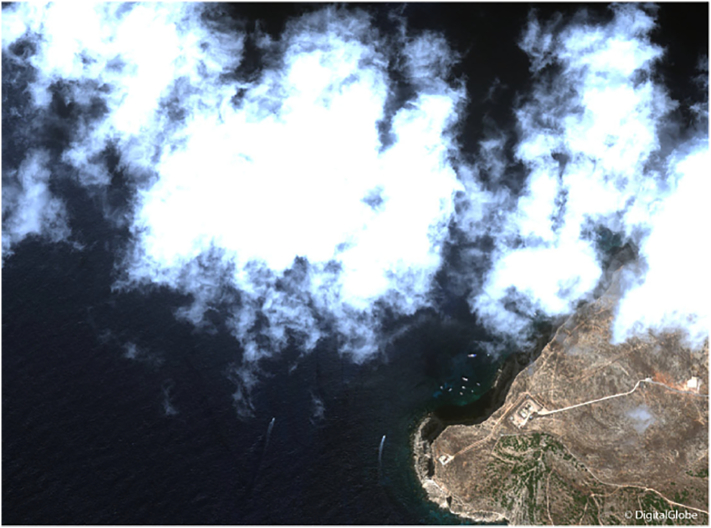
Detail of a WorldView-2 image with a spatial resolution of 1.8 m of the Western region of Lampedusa (Italy), acquired in September 2013 (RGB composite). This image illustrates the difficulty of detecting vessels when much of the scene is obscured by clouds.